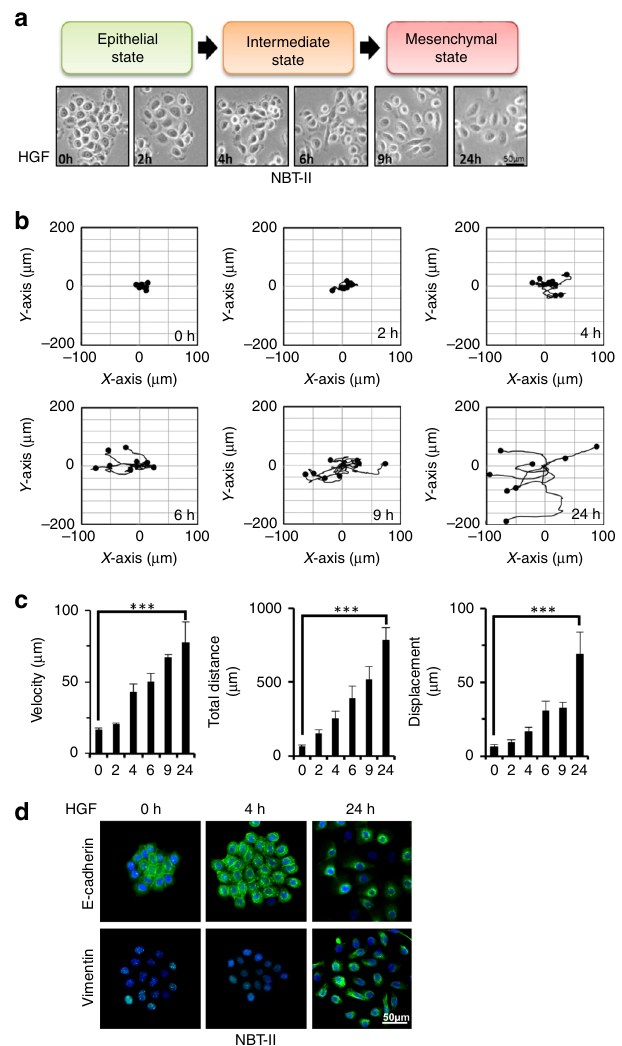
Fig. 1 HGF-induced EMT in NBT-II carcinoma cells. a Phase contrast images of NBT-II cells at 0, 2, 4, 6, 9 and 24 h post HGF induction. Scale bars: 50 μ m. b Cell tracks of NBT-II cells at 0, 2, 4, 6, 9 and 24 h post HGF induction. Data shown are representative of three independent and reproducible experiments. c Bar charts display velocity (left panel), total distance (middle panel) and displacement (right panel) of NBT-II cells over 24 h. Bars represent mean ± SD of three independent experiments. A two-tailed Student ’ s t test compares the treated versus untreated cell populations, *** P < 0.001. d Representative immuno fl uorescence images of NBT-II stained with E-cadherin and Vimentin at 0, 4 and 24 h post HGF.